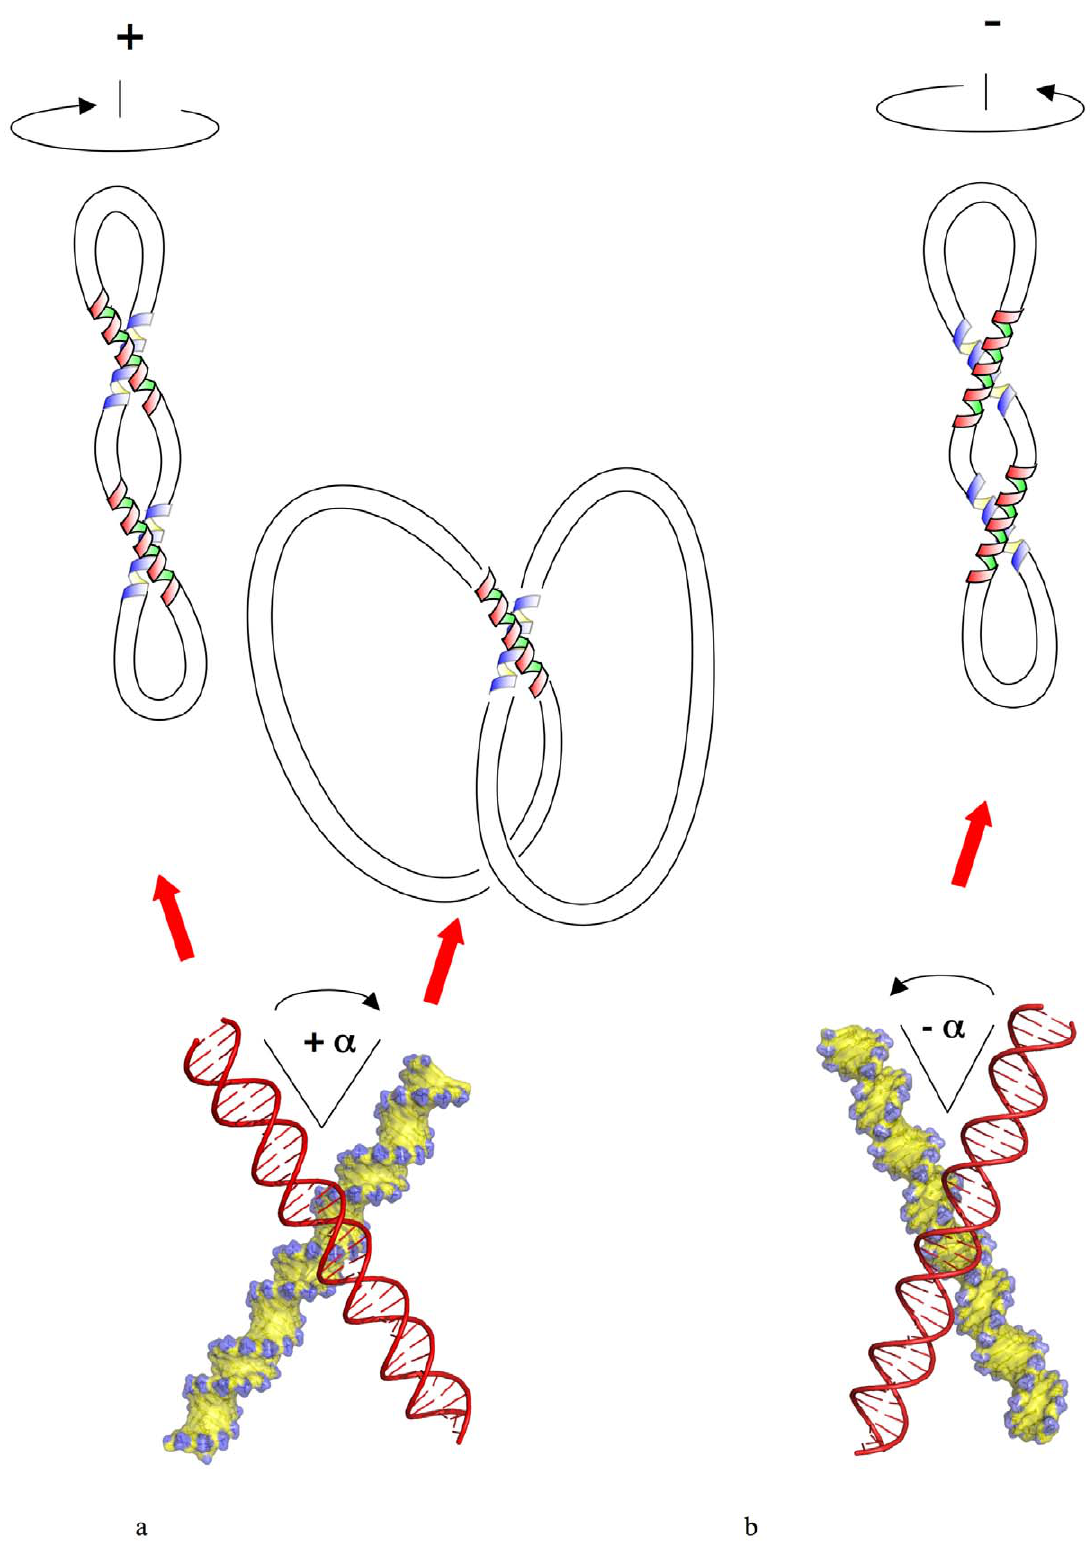
Figure 1. Properties of DNA crossovers and their link to DNA topology. In ( + )sc DNA, the plectoneme forms a left-handed superhelix with right-handed crossovers (clockwise rotation for closing the small angle). In ( 2 )sc DNA, the plectoneme forms a right-handed superhelix with left- handed crossovers. (a) Schematic representation of ( + )sc DNA and catenanes with right-handed crossovers formed by groove-backbone interaction between two B-DNA duplexes, as found in crystallographic structures. (b) Schematic representation of ( 2 )sc DNA with left-handed crossovers formed by the juxtaposition of the major grooves of two B-DNA duplexes, as found in crystallographic structures.